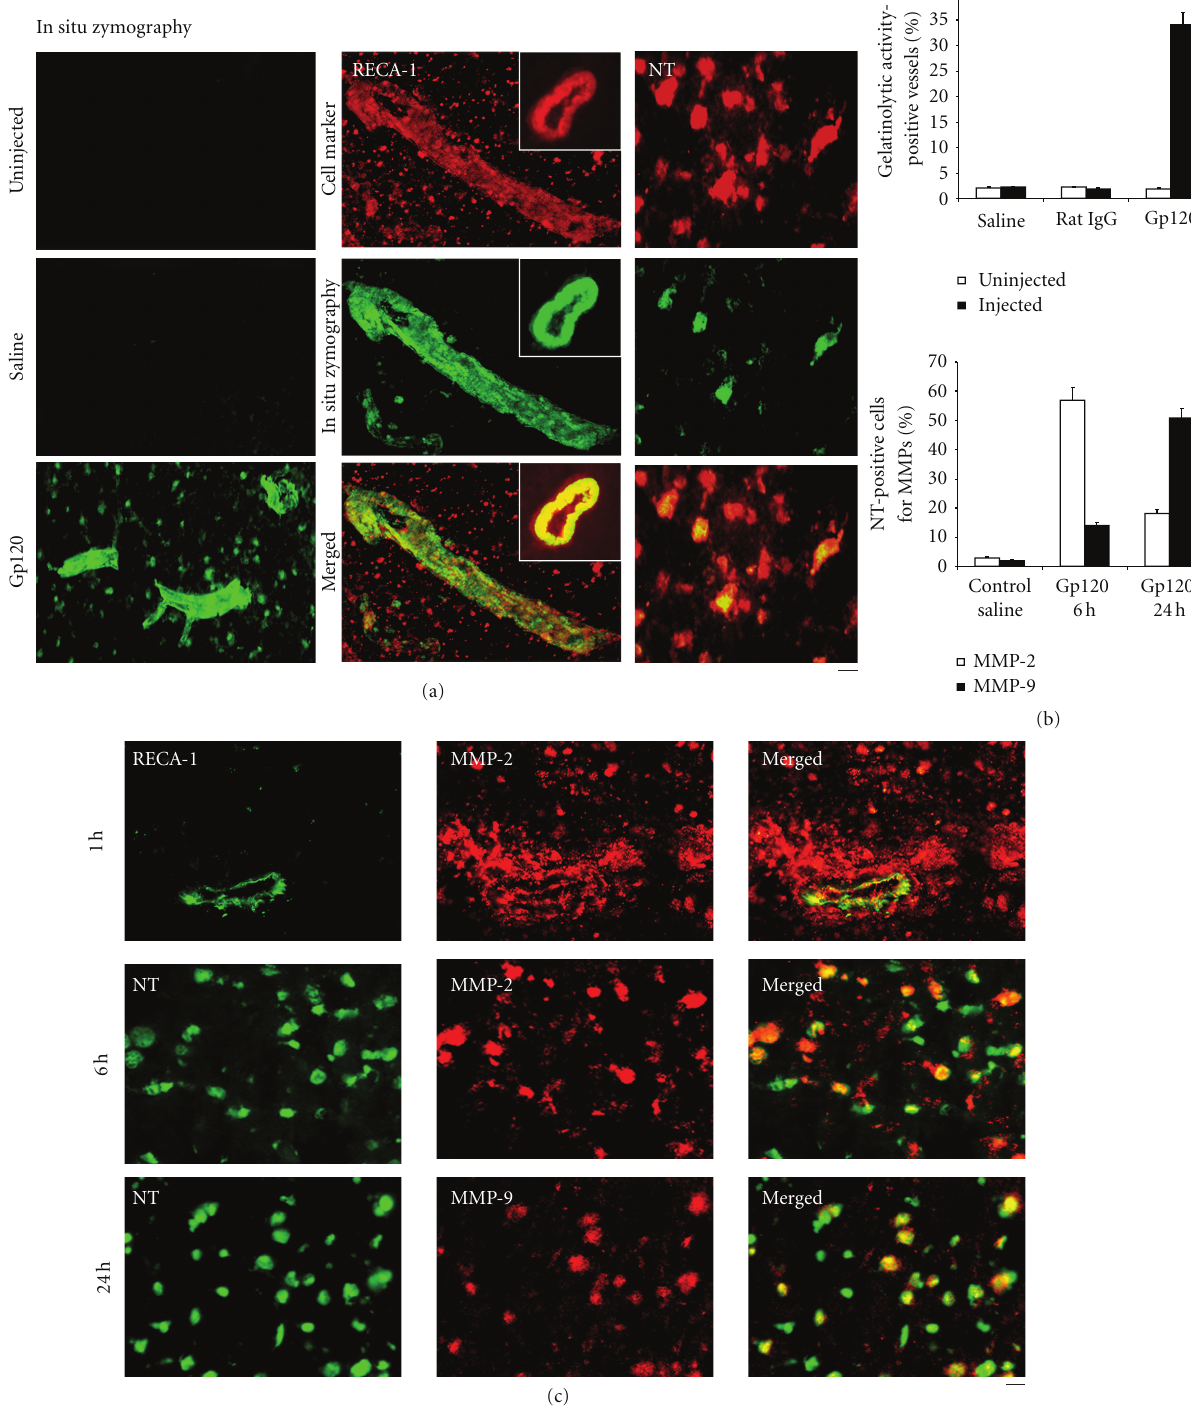
Figure 3: Injection of gp120 into the rat CP induced upregulation of matrix metalloproteinases (MMPs). (a) Frozen cryostat sections of CP injected with 500 ng gp120 and stained by in situ zymography. Left column: the fluorescent product was observed in blood vessel-like structures and in cells. No gelatinolytic activity was seen in the controlateral uninjected side or in CPs injected with saline. There was a colocalization between in situ zymography and RECA-1 and Neurotrace (NT), a marker of neurons (resp., middle and right columns). (b) Top: numbers of vessels exhibiting gelatinolytic activity were increased in CPs injected with gp120. Bottom: increase in the numbers of MMP-2- and MMP-9-positive neurons in CPs injected with gp120. (c) Colocalization between MMP-2, MMP-9, NT, and RECA-1 in CPs injected with gp120. Bar: (a) left column: 100 μ m, middle column: 70 μ m, left column: 30 μ m; (c) first row: 50 μ m, 2nd row: 40 μ m, 3rd row: 40 μ